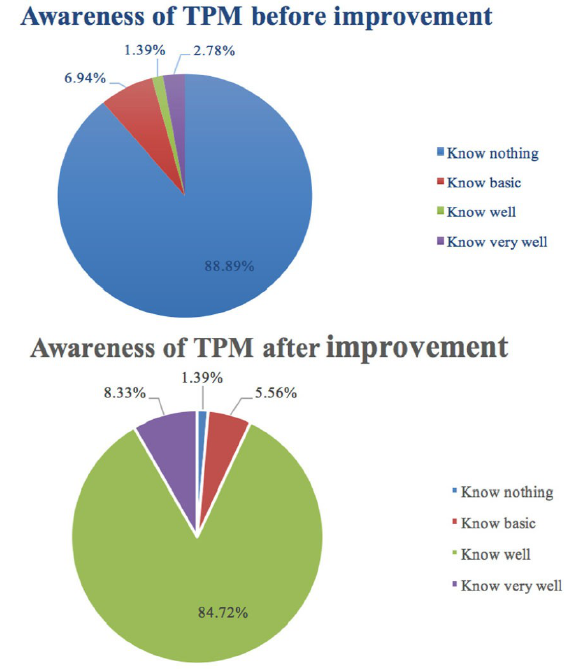
Figure 12. Comparison of TPM awareness before and after